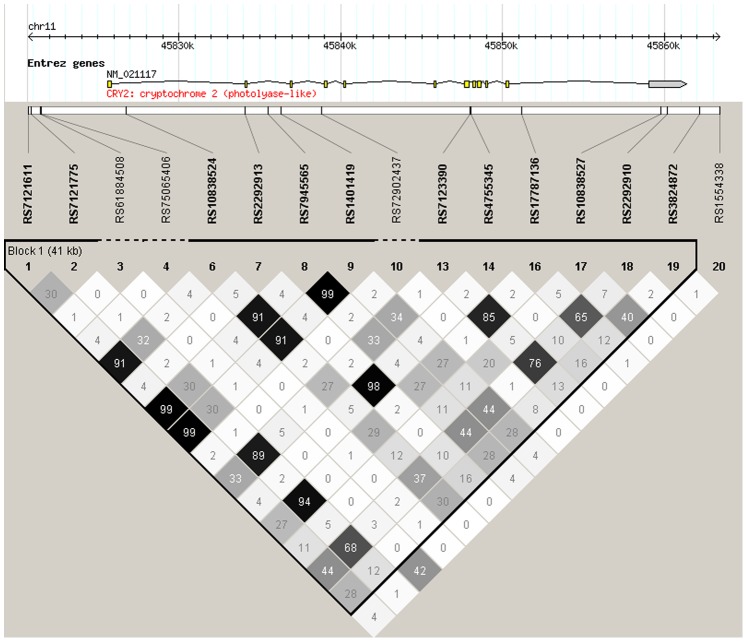
The analyzed CRY2 SNPs, their location and the haplotype block structure constructed using the Haploview program showing r2 values.